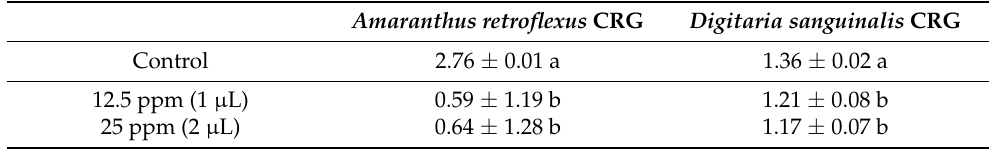
Figure 1. Effects of a mixture of VOCs, prepared by mimicking the volatile profile of Cytisus scoparius flowering foliage or only flowers, assayed at 12.5 and 25 ppm in Petri dishes, on the total percentage of germinated seeds (Gt) and early growth of two agricultural weed species ( Amaranthus retroflexus and Digitaria sanguinalis ). Mean values of four replicates are represented in percentage relative to control. Error bars represent standard deviation (S.D.). For each target weed species, p - and F-values of the effects of treatments from one-way ANOVA or Kruskal-Wallis H tests are shown. Mean values labeled with distinct letters denote statistically significant differences among treatments (post hoc LSD or Tamhane’s T 2 test). Table 1. Effects of a mixture of VOCs, prepared by mimicking the volatile profile of Cotises scoparius flowering foliage or only flowers, assayed at 12.5 and 25 ppm in Petri dishes, on the germination index (CRG) of two agricultural weed species ( Amaranthus retroflexus and Digitaria sanguinalis ). Values represent the means of four replicates ± standard deviation (S.D.). For each species, mean values labeled with distinct letters are significantly different at p ≤ 0.05 (post hoc LSD or Tamhane’s T 2 test).